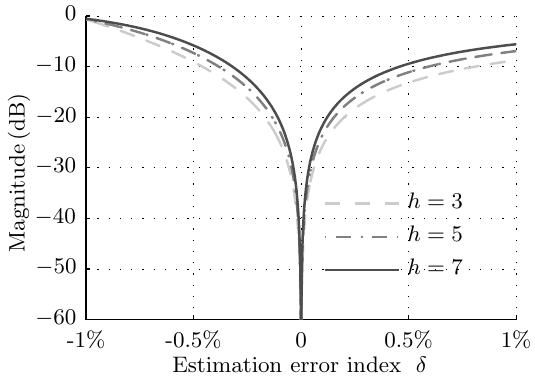
as a function of the grid frequency estimation error δ , s = j 2 π h ˆ f g ( 1 + δ )